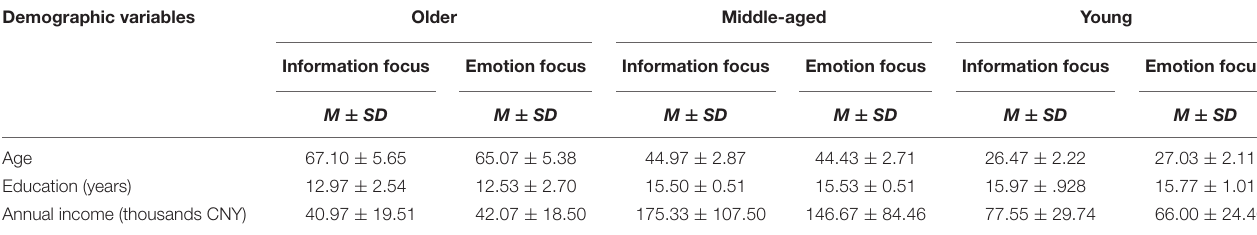
TABLE 1 | Descriptive statistics for age, education, and annual income by age group and focus condition. Demographic variables